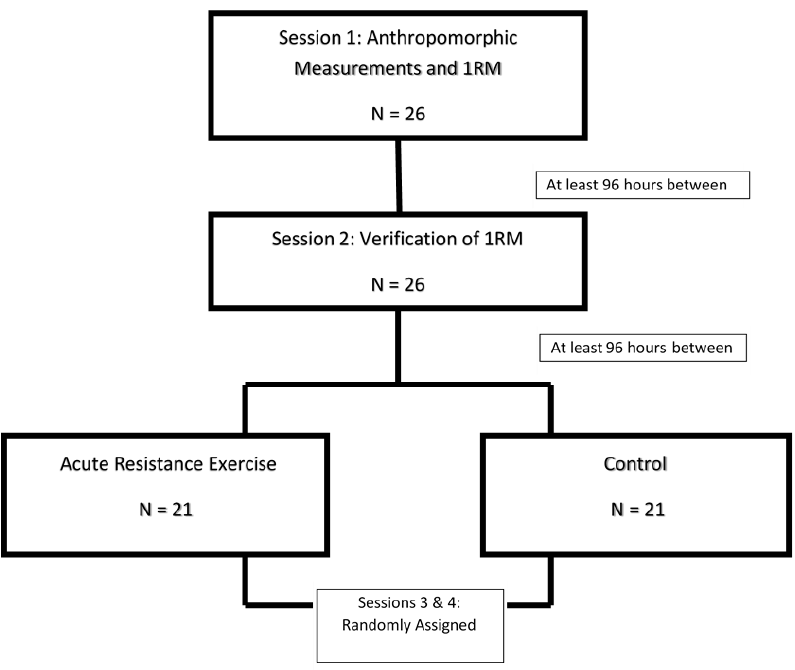
Figure 1. Flowchart of study design. 1RM—one-repetition maximum.